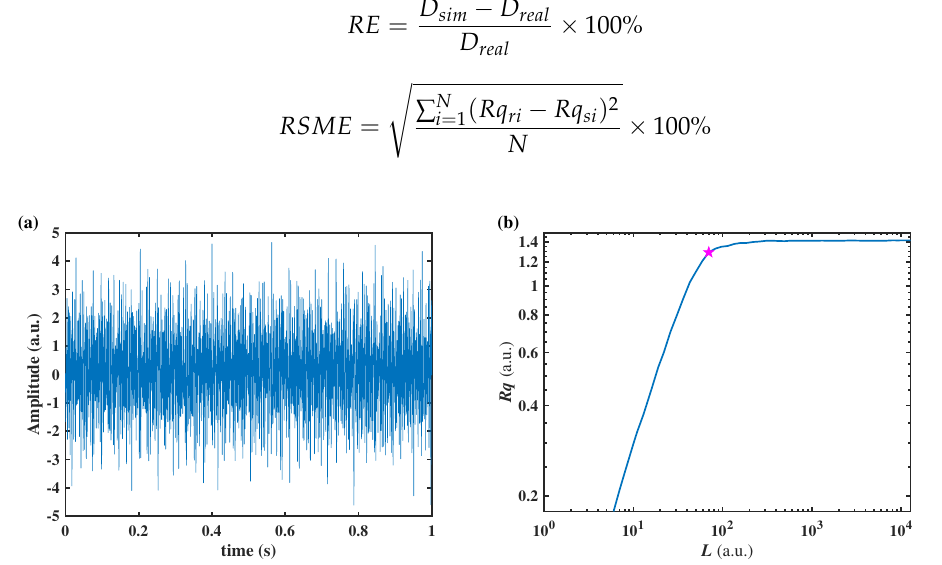
Figure 14. ( a ) The simulated signal, ( b ) the Rq - L curve of the simulated signal and the star is the position of